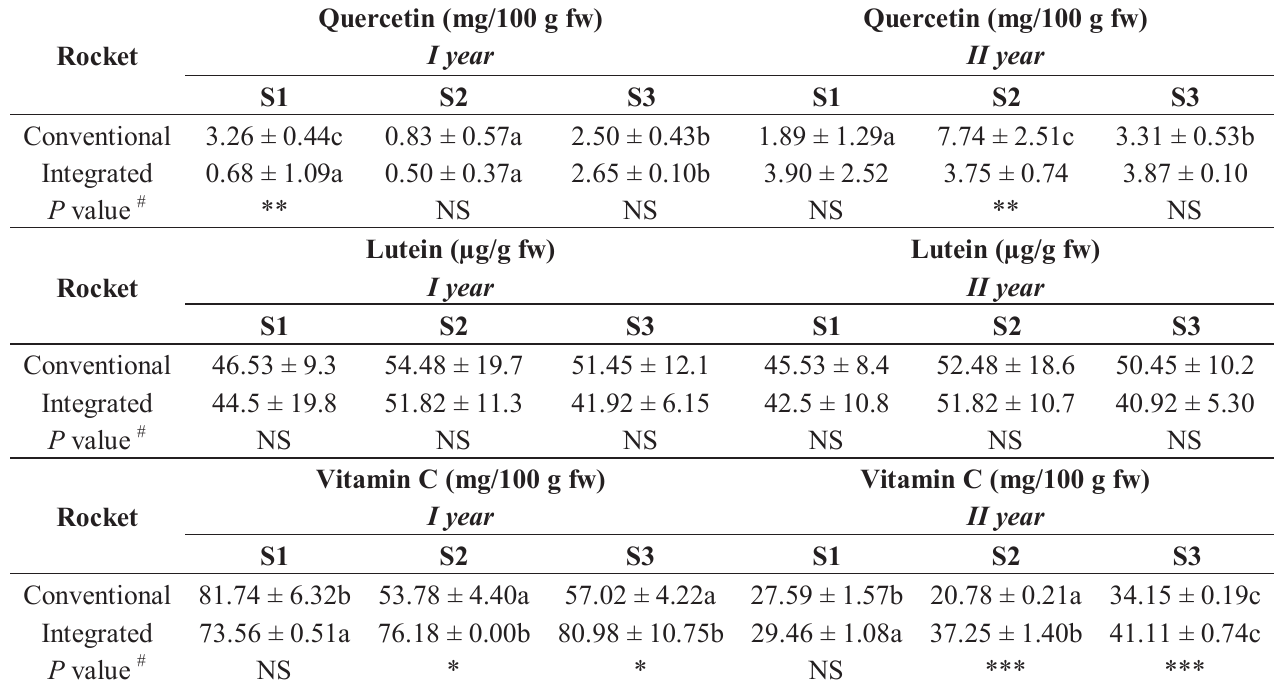
Table 1. Bioactive molecules in rocket by agronomic practice and year of cultivation (cid:525) .